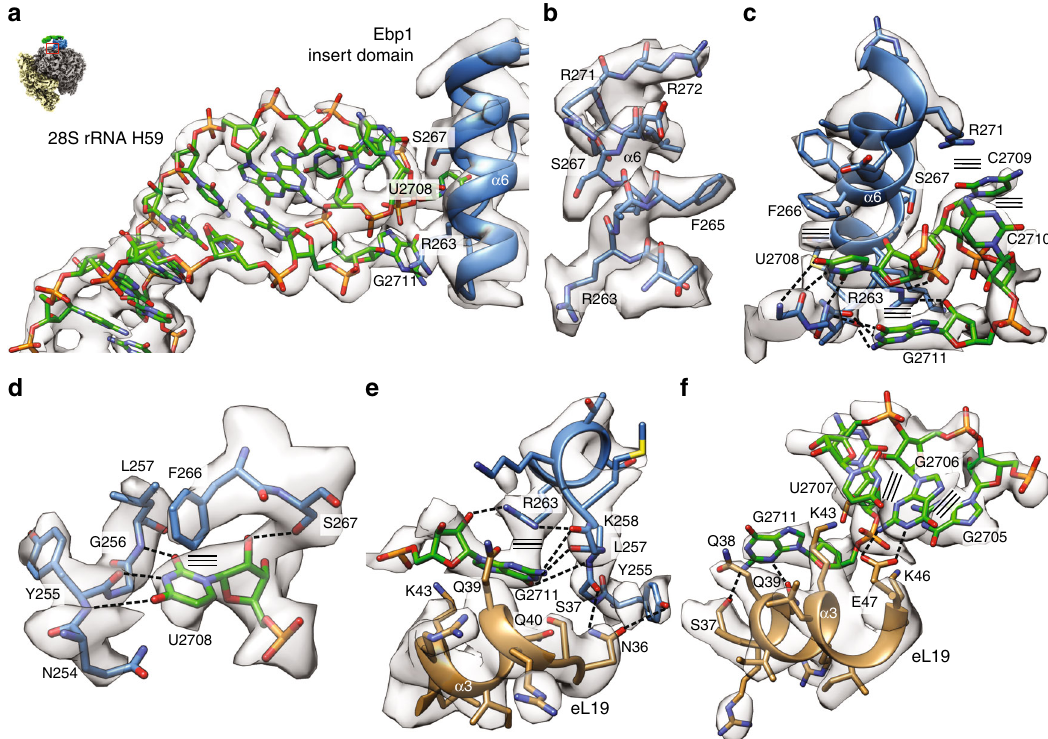
Fig. 4 H59 forms a dynamic adaptor for Ebp1 binding. a The H59 – Ebp1 interface. Atomic models of rRNA H59 (green) and Ebp1 helix α 6 (blue) are superposed to the cryo-EM density (transparent gray). Overall orientation as in Fig. 3a and as indicated by the small representation in the corner. b Exemplary cryo-EM density of the Ebp1 – ribosome interaction for the Ebp1 helix α 6. c Structural details of the Ebp1 – H59 interaction. Hydrogen bonds (dashed lines) and stacking interactions (parallel lines) are indicated. View is vertically rotated by 180° in respect to panels ( a ) and ( b ). d The Watson – Crick like readout of U2708. e Structural details of the Ebp1 – H59 – eL19 (brown) interaction around the bulged-out G2711 nucleotide. f H59 in the Ebp1-docked position rolled onto eL19 helix α 3. In all panels, the cryo-EM density after 2-body multibody re fi nement is shown (transparent